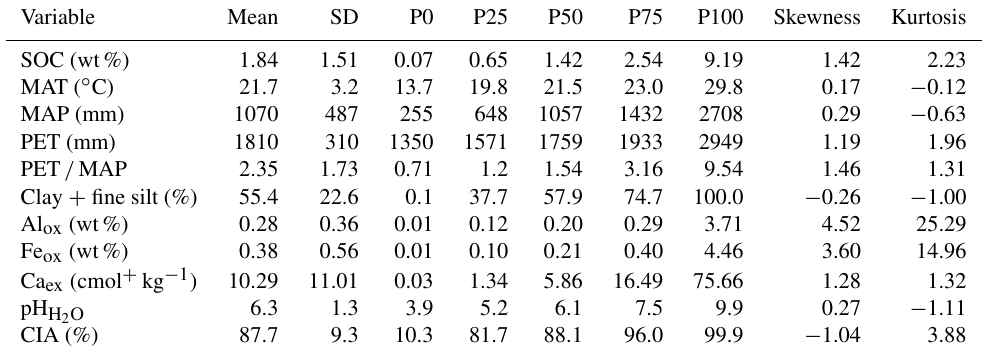
Table 2. Summary statistics of all numerical soil and climate variables for the entire data set ( n total = 1601; n Topsoil = 791; n Subsoil = 810).